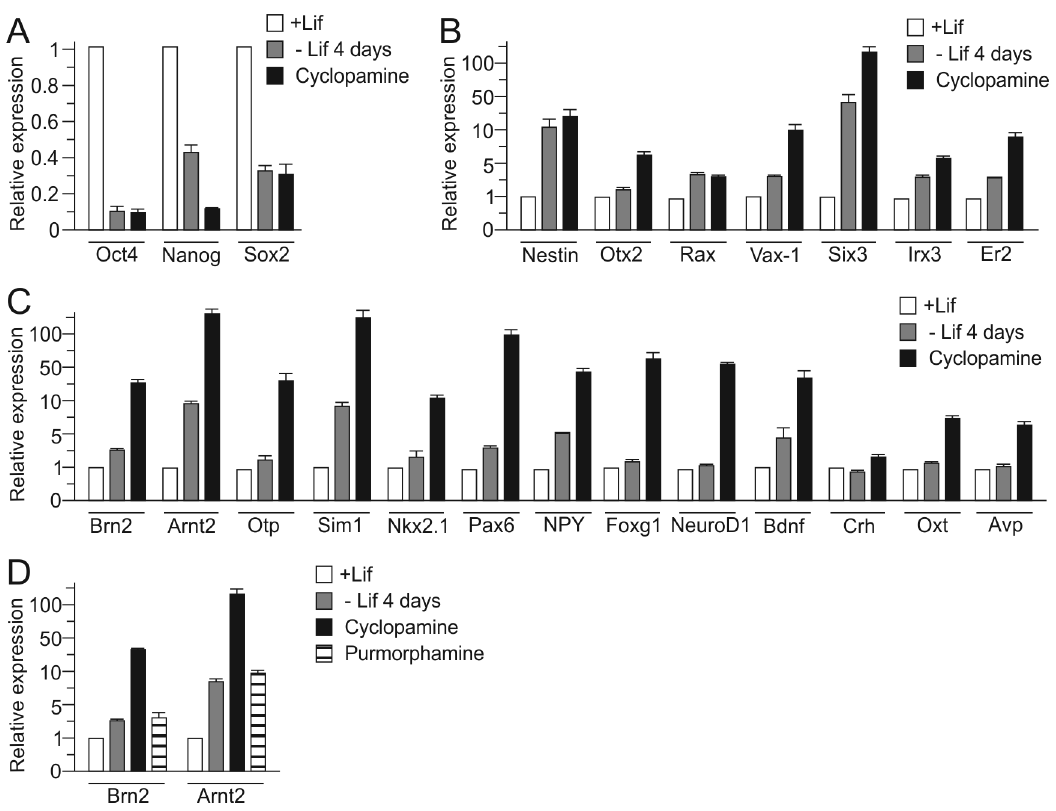
Figure 1. Hypothalamic-like differentiation of the embryonic stem cell line EB5. A, Pluripotency factors rapidly decreased in differentiating EB5 cells over 4 days following withdrawal of leukemia inhibitory factor (-Lif) as evidenced by qRT-PCR analysis. B, Markers for neuroectoderm and rostral hypothalamic development conversely increased during EB5 cell differentiation. C, qRT-PCR analysis of markers for dorsal-ventral hypothalamic patterning and PVN neurons demonstrated strong increases following 25 days of differentiation. D, PVN markers ( Brn2 and Arnt2 ) further increased following treatment with the sonic hedgehog (Shh) antagonist cyclopamine as evidenced by qRT-PCR. Application of the Shh agonist purmorphamine blocked this increase. Bars represent standard deviations from the mean (sem) from at least 3 independent